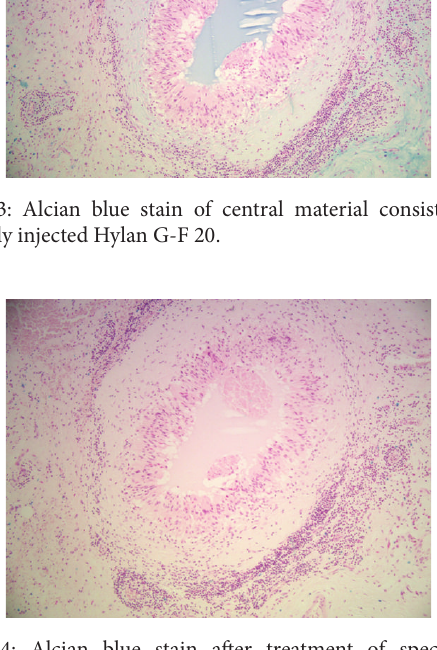
Figure 4: Alcian blue stain after treatment of specimen by hyaluronidase. Lack of staining in centre of granuloma indicative of enzymatic